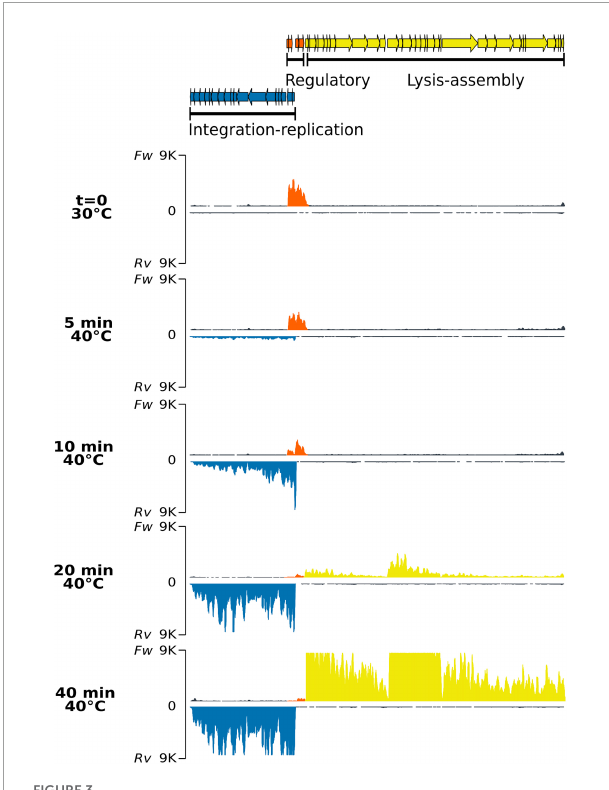
FIGURE3 Strand-specific RNA-Seq of the phage genome after thermo-induction of lysogen PAO1(Fc02 repc ts). Samples of the lysogen culture grown at 30 ◦ C correspond to the uninduced culture (t = 0), and samples after being up-shifted to 40 ◦ C were drawn at the indicated times. For each time sample, the upper trace corresponds to RNA reads mapped to the forward strand ( Fw ) and the lower trace, in an inverted scale, to the reverse ( Rv ) strands for each pair. The colors of the read-blocks correspond to the group of genes in the gene map at the top of the figure: orange, genome region transcribed during lysogeny at 30 ◦ C; blue, left-arm lytic cycle genes, and yellow, right-arm lytic cycle genes. The histogram for the reads was generated by ggplot with 9 K reads maximum set (vertical axis) and map length in nucleotides (horizontal axis).